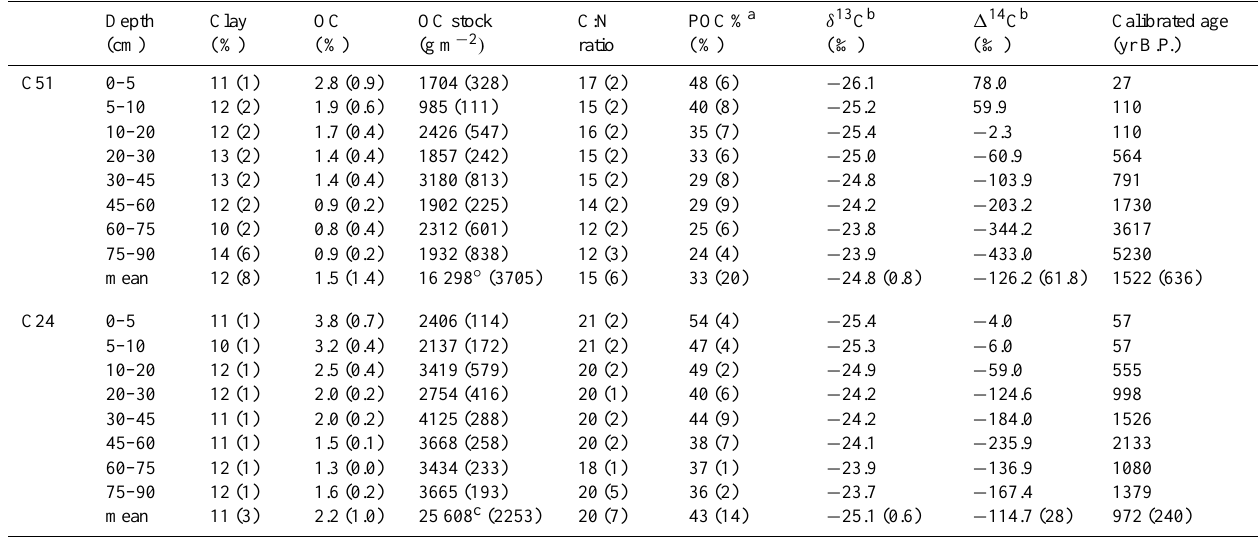
Table 2. Bulk density (BD), clay content, OC concentration, C:N ratio, POC% (percentage of OC > 53µm), δ 13 C, 1 14 C and calibrated age (yr B.P.) in soil samples (standard error in brackets).